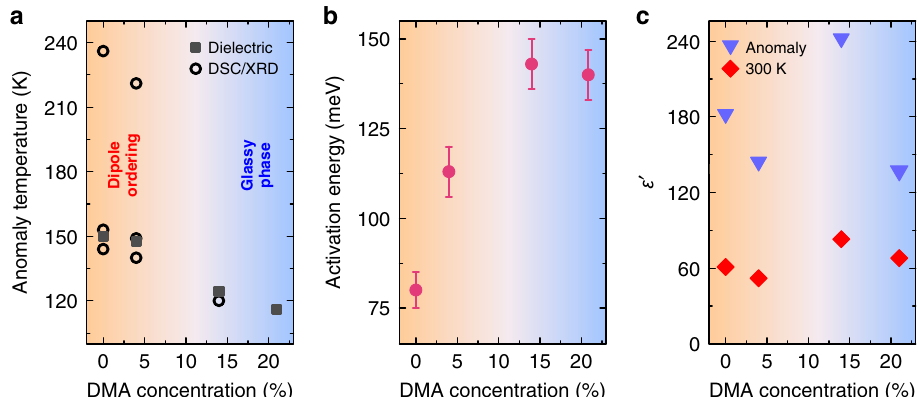
Fig. 7 Summary of experimental results. DMA concentration dependence of a phase transition and dielectric anomaly temperatures, b activation energy of molecular cation motion and c dielectric permittivity of the anomaly (129 Hz) and at 300 K (1 MHz). The bluish part of the phase diagram marks the glassy behavior of the electric dipoles. If not indicated, the error bars are smaller than the